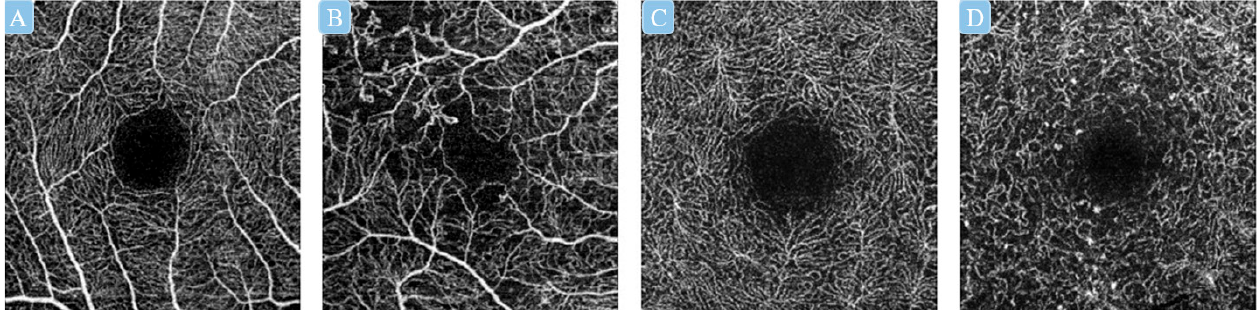
Figure 4. Examples of optical coherence tomography angiography (OCT-A) images in classifications of diabetic macular ischemia (DMI) on superficial capillary plexus (SCP) and deep capillary plexus (DCP). DMI classification from left to right: no DMI on SCP ( A ), DMI on SCP ( B ), no DMI on DCP ( C ), DMI on DCP ( D ). OCT-A: optical coherence tomography angiography; SCP: superficial capillary plexus; DCP: deep capillary plexus; DMI: diabetic macular ischemia.